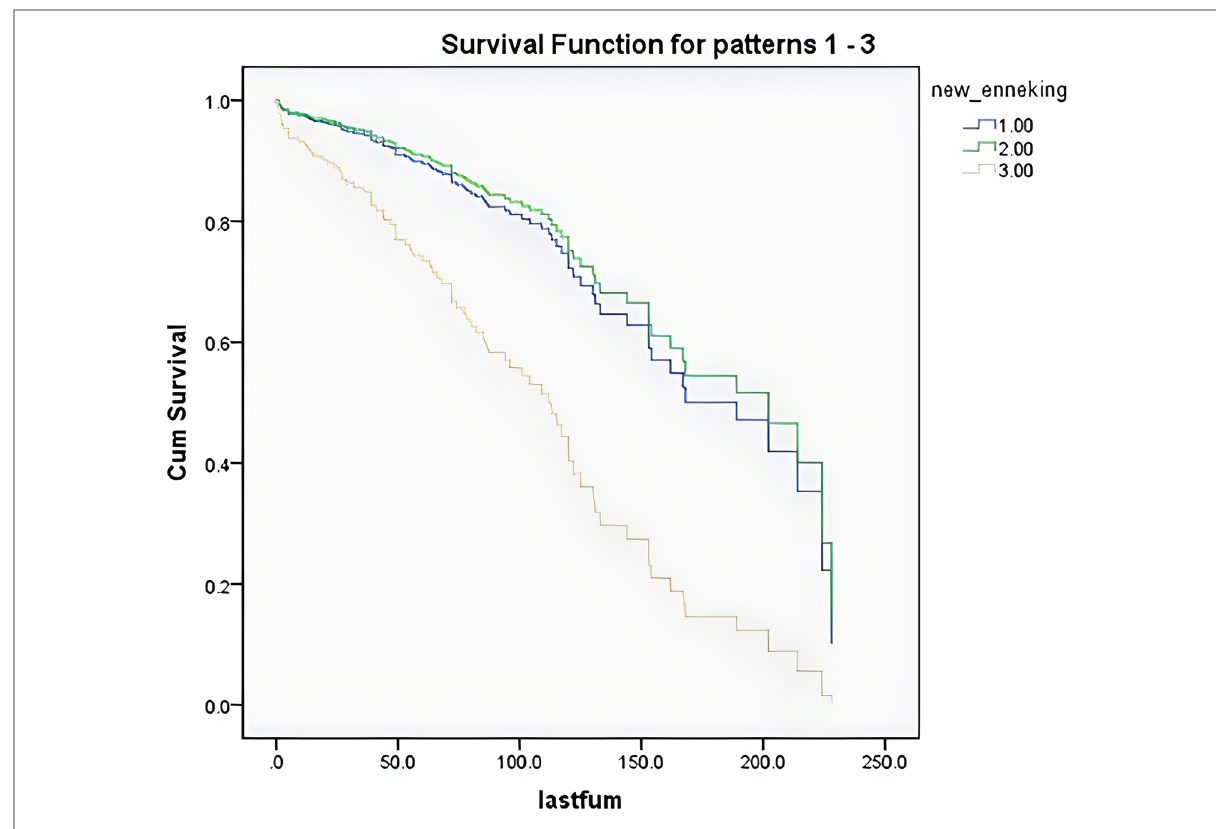
FIGURE 4 Survival curves of the patients after discretization by Enneking